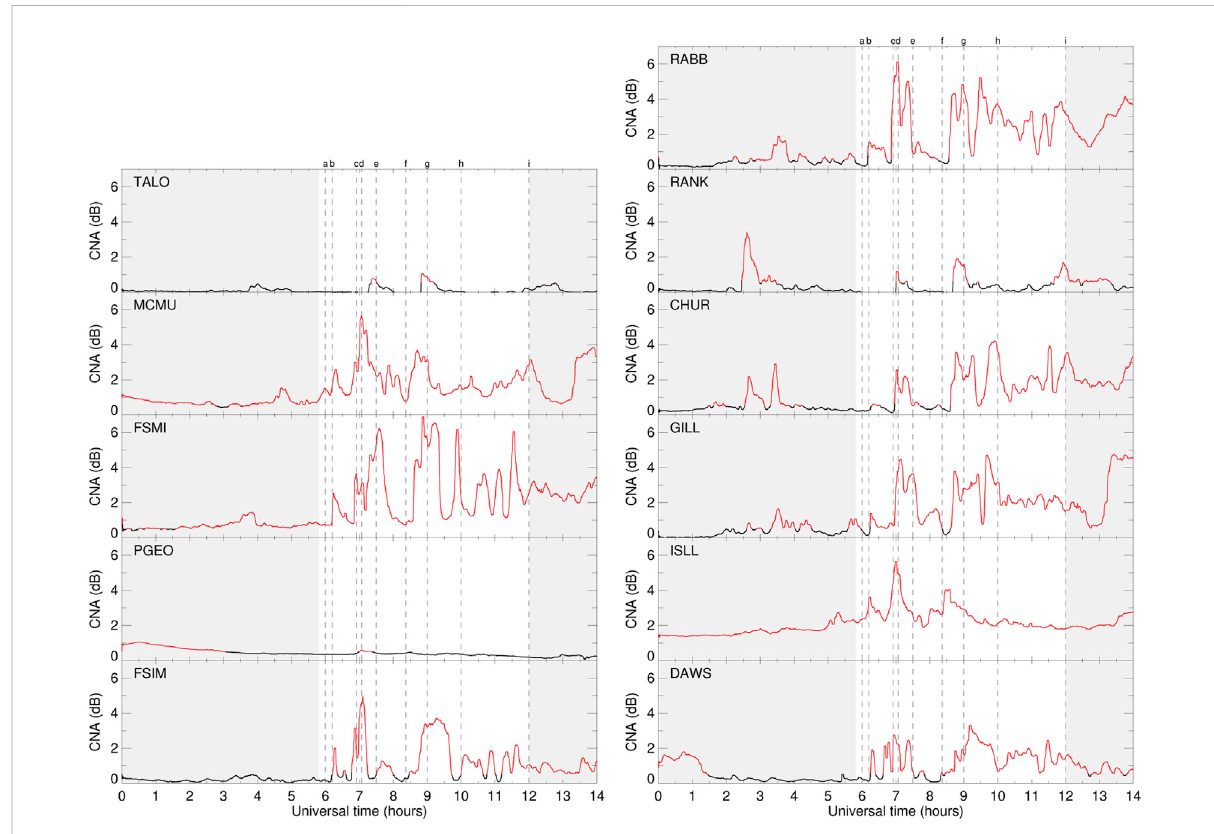
FIGURE 3 30 MHzcosmicnoiseabsorption(CNA)measurementsfromtheGo-Canadariometernetworkon25October2019.CNAmeasurementsbelow the threshold value of 0.5 dB are coloured black. The vertical dashed lines correspond to the time intervals shown in Figure